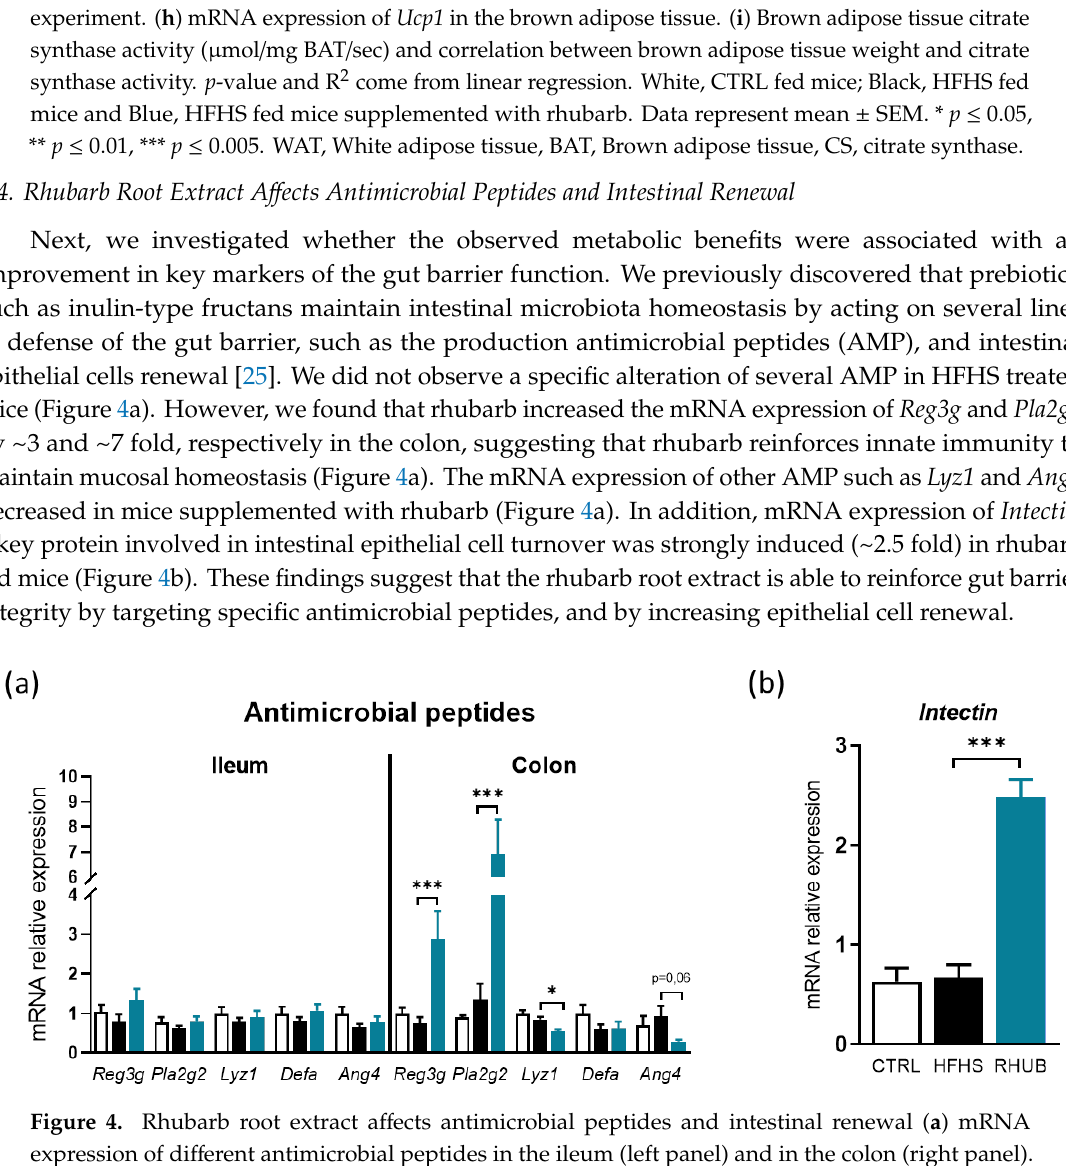
Figure 4. Rhubarb root extract affects antimicrobial peptides and intestinal renewal ( a ) mRNA expression of different antimicrobial peptides in the ileum (left panel) and in the colon (right panel). ( b ) mRNA expression of intectin in the colon. White, CTRL fed mice; Black, HFHS fed mice and Blue, HFHS fed mice supplemented with rhubarb. Data represent mean ± SEM. * p ≤ 0.05, ** p ≤ 0.01, *** p ≤